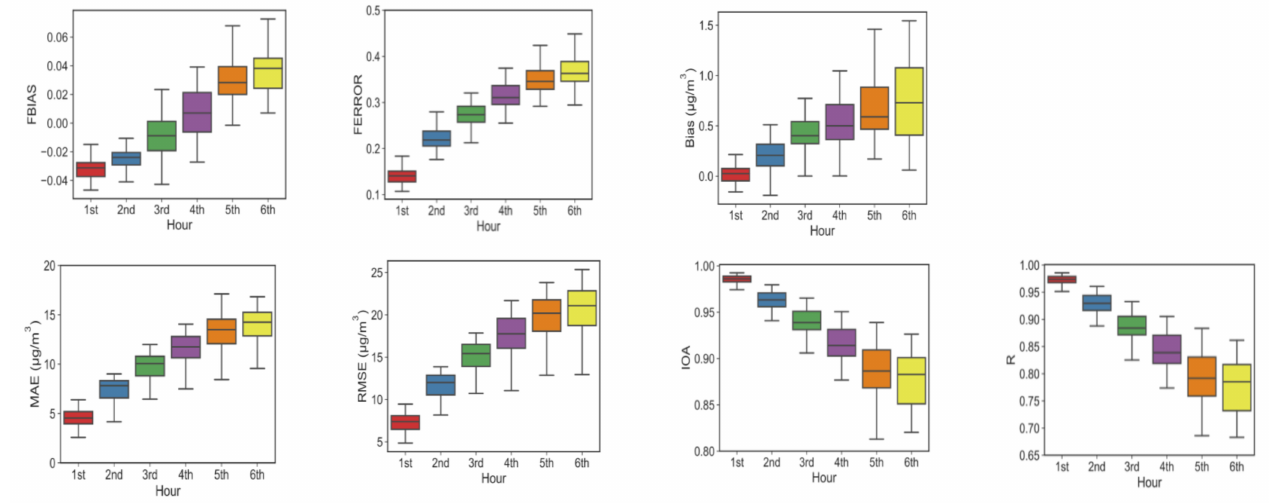
Figure 7. Boxplot of performance indicators with different forecast